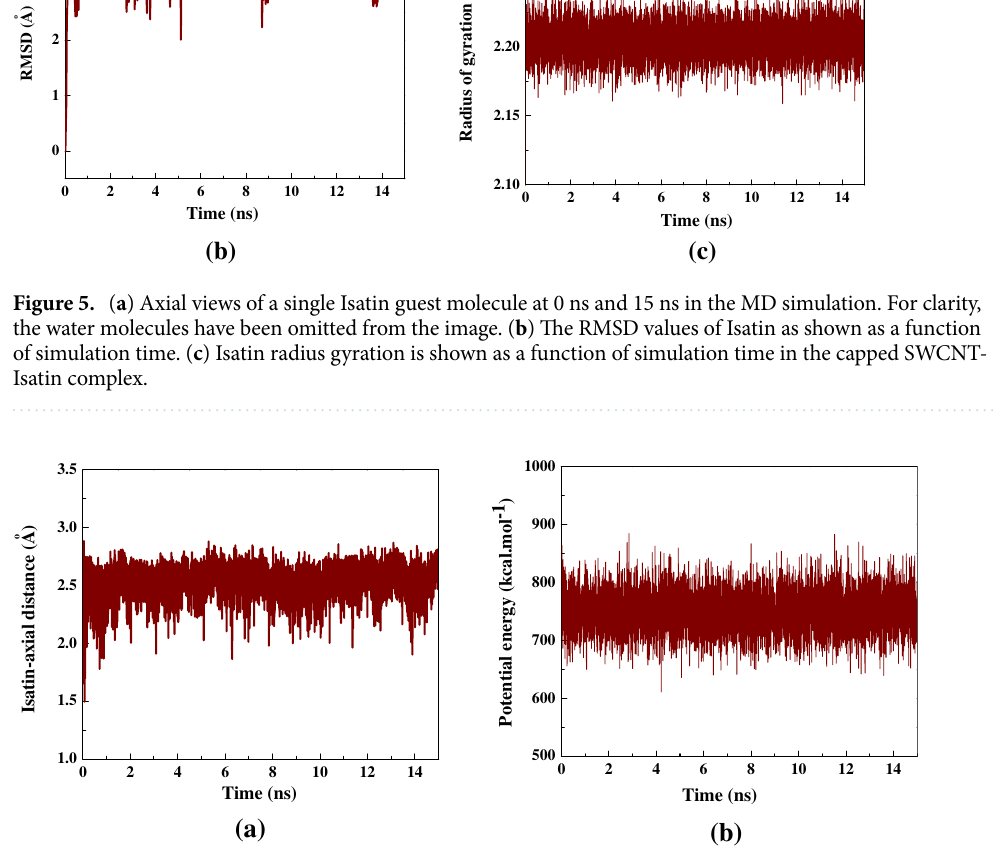
Figure 6. ( a ) The distance between Isatin’s CoM and the central axis of capped SWCNT as a function of simulation time. ( b ) The potential energy variation of Isatin inside the capped SWCNT-Isatin complex as a function of simulation